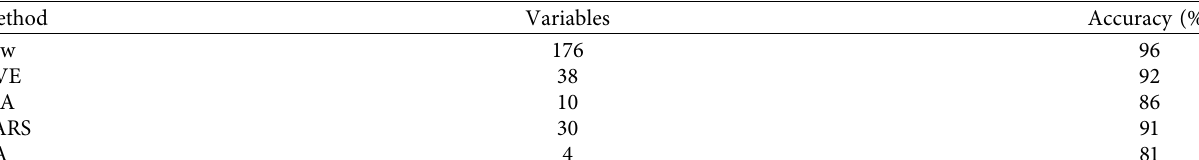
Table 2: Model optimization results by UVE, SPA, CARS, and GA.